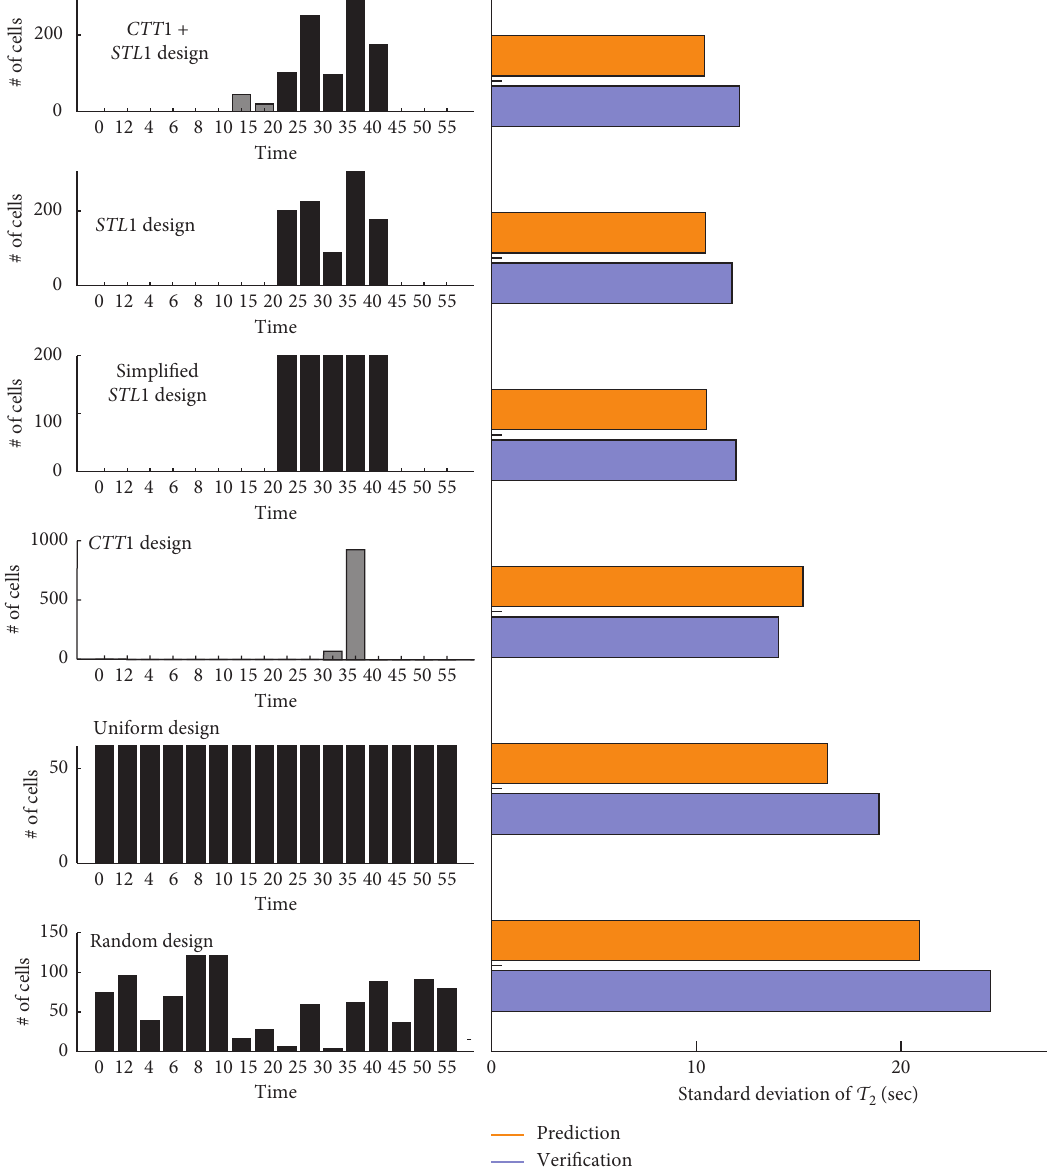
Figure 6: Verification of the uncertainty in τ for different experiment designs. The left panel shows various experiment designs, where the 2 sum of the bars (i.e., the total number of measurements) is 1,000. Gray bars represent the measurements of CTT 1 and black bars STL 1. The right panel shows the value of the objective function in equation (15) for each experiment design in orange, and the RMSE values for verification are shown in